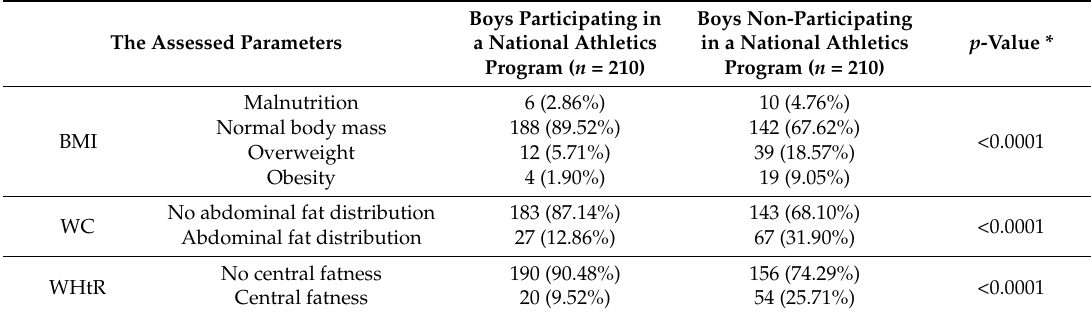
Table 4. The assessment of body mass and abdominal fat distribution in group of boys participating in a national athletics program and pair-matched control group of boys.